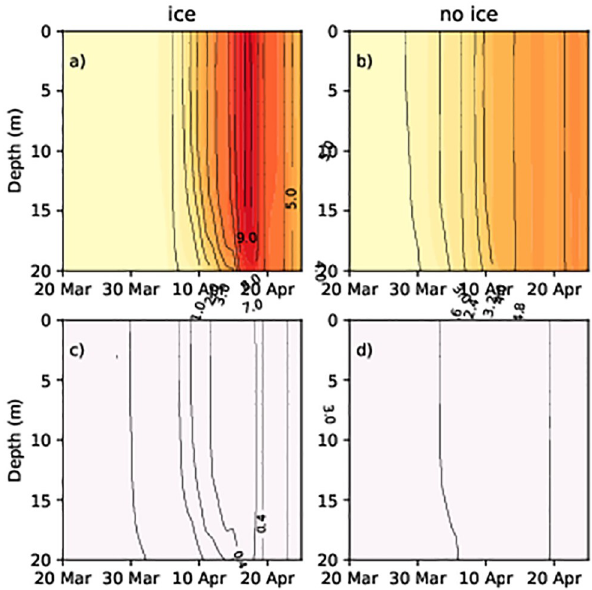
Fig 8. Diatom and dinoflagellate concentrations (Chl mg/m 3 ) at station 32 in spring 2013. (a) Diatoms (no ice run); (b) diatoms (ice run); (c) dinoflagellates (no ice run); (d) dinoflagellates (ice run).